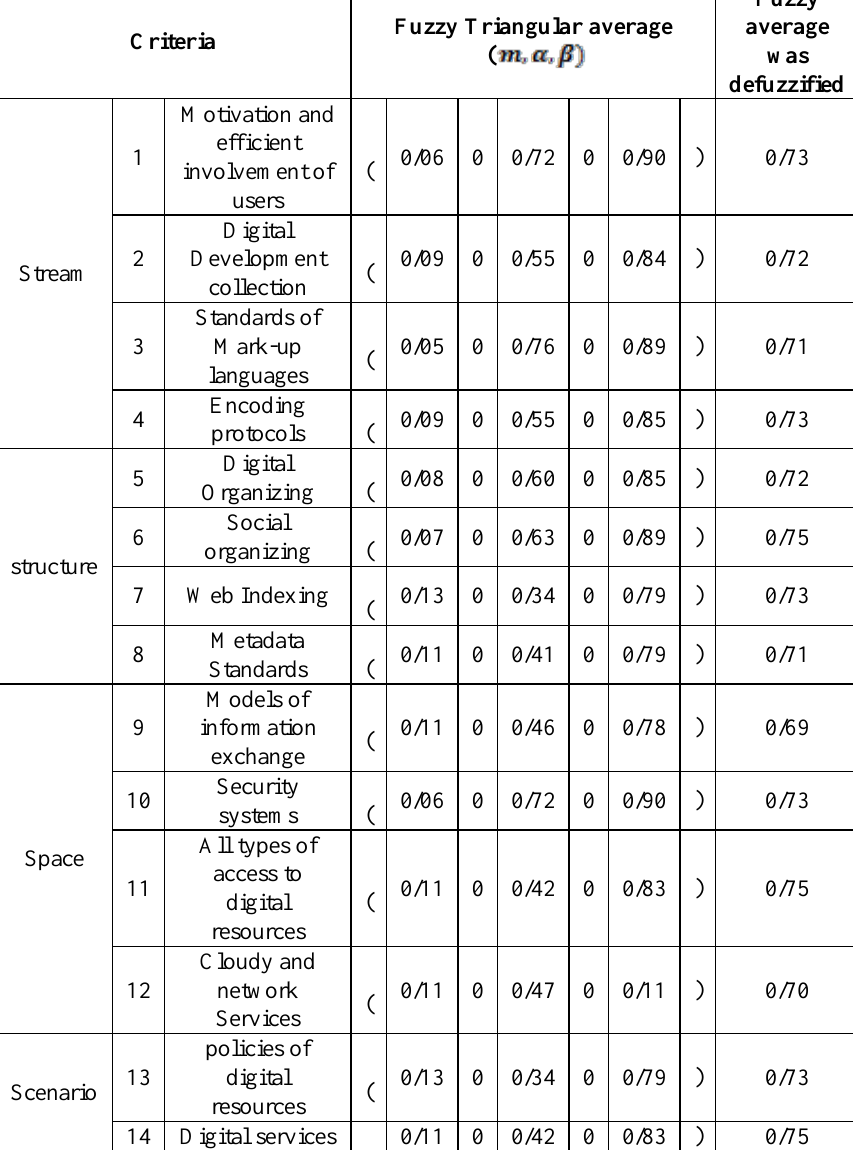
Table 5. Average of expert's points of view resulted from the second poll